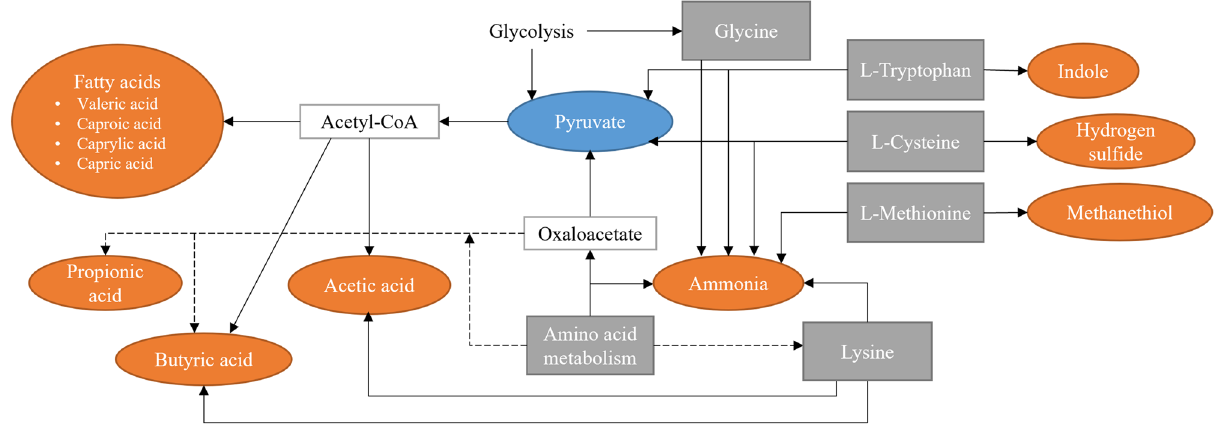
Figure 6. Summary of the most important metabolic routes for the formation of the VOCs found to significantly change in the presence of amoxicillin and in hemin-limited conditions. Modified from the KEGG database 38,39 for P. gingivalis ATCC 33277 and Nelson et al. 40 . Amino acids are shown in gray, important intermediates in white, and the main volatile products in orange. Pyruvate, an important product and an intermediate is shown in blue. Dashed lines indicate multiple intermediate